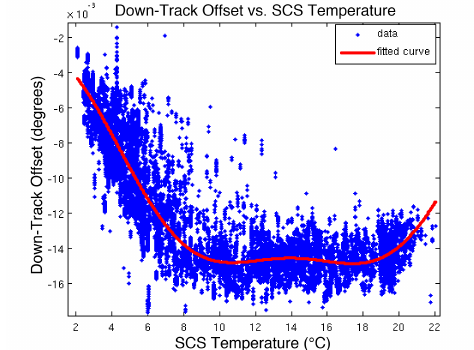
Figure 6. Best-fit curves for the down-track offset between the NAC-L to NAC-R. Blue dots are individual co-registration points within an image. Red line is the best-fit curve (2 nd order Fourier series). Y-axis units are 10 -5